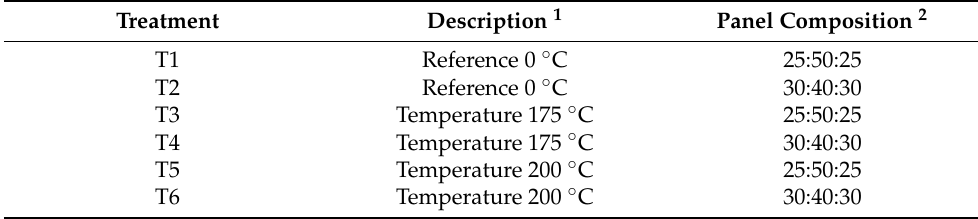
Table 1. Treatments analyzed.